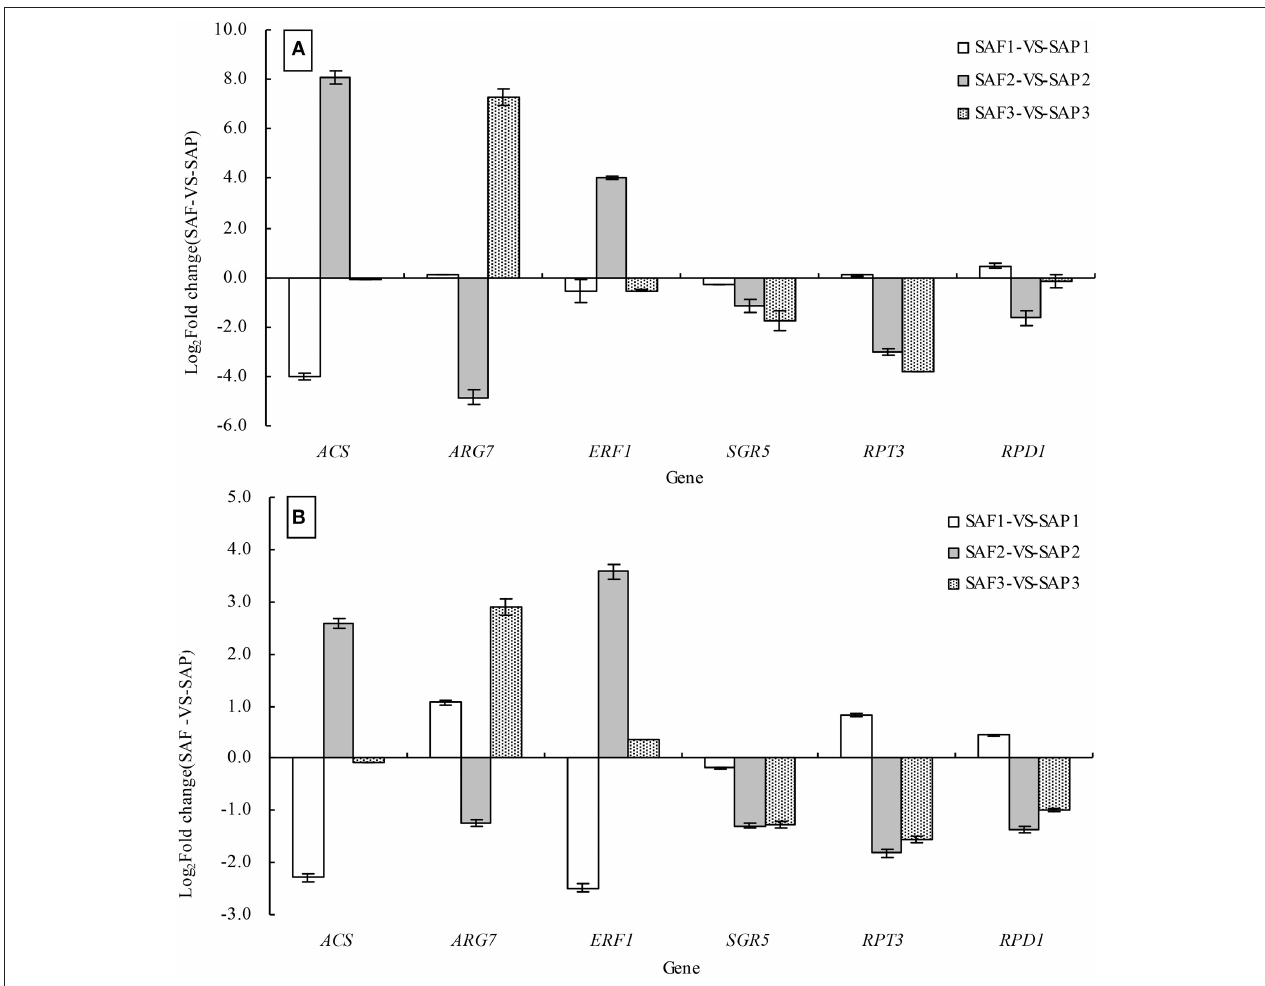
FIGURE 8 | Validation of DEGs by qRT-PCR analysis. Note: the relative expression levels of six differential expressed genes in three development stages of primocanes and floricanes were obtained by RNA-seq using RPKM method (A) and by qRT-PCR using the 2 − 11 CT method (B) . Bars represent mean ± SE ( n =